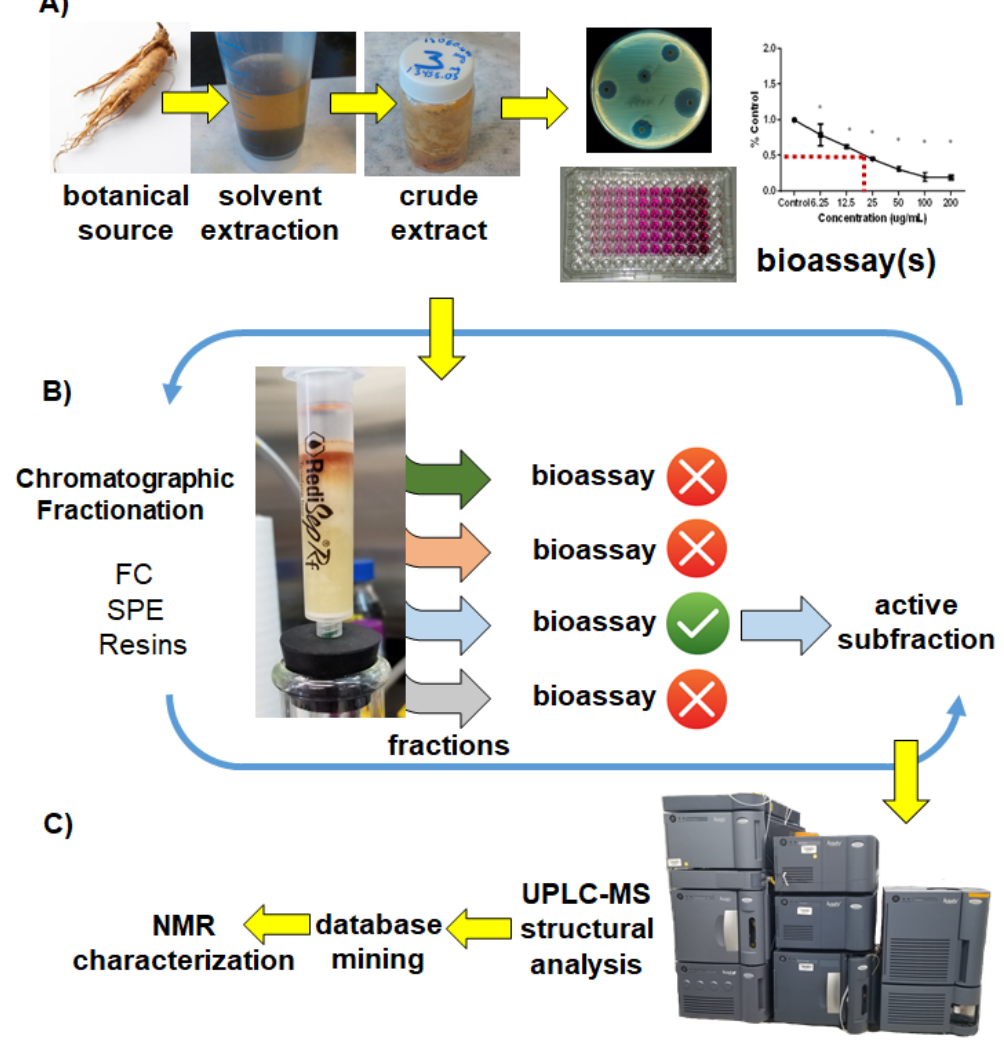
Figure 1. Classic assay-guided fractionation model. ( A ) Crude extracts are prepared, bioassayed, and triaged for importance; ( B ) bioactive crudes are chromatographically fractionated into simpler mixtures. Each fraction is bioassayed and further purified through iterative rounds of chromatography; ( C ) active compounds are identified and characterized via analytical platforms including ultra-performance liquid chromatography mass spectrometry (UPLC-MS), database queries and nuclear magnetic resonance (NMR) structural elucidation.